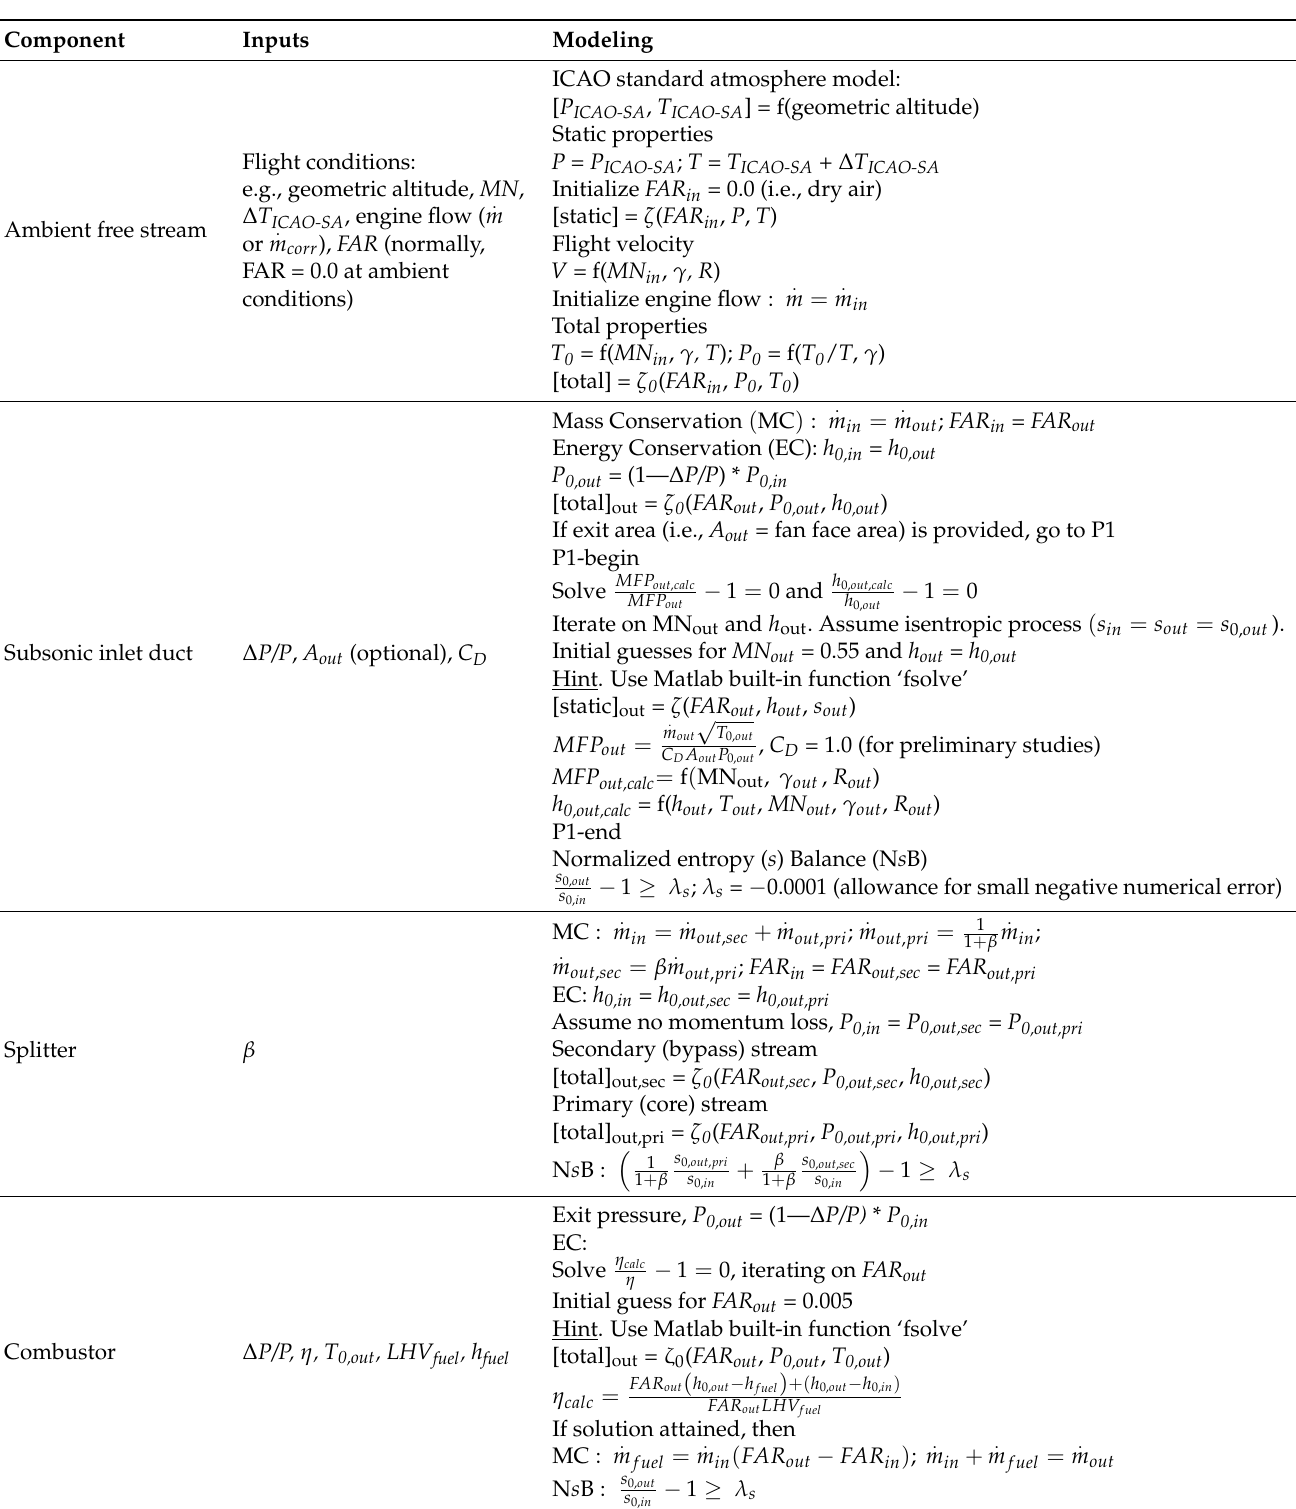
Table A1. Detailed aerothermodynamic DP